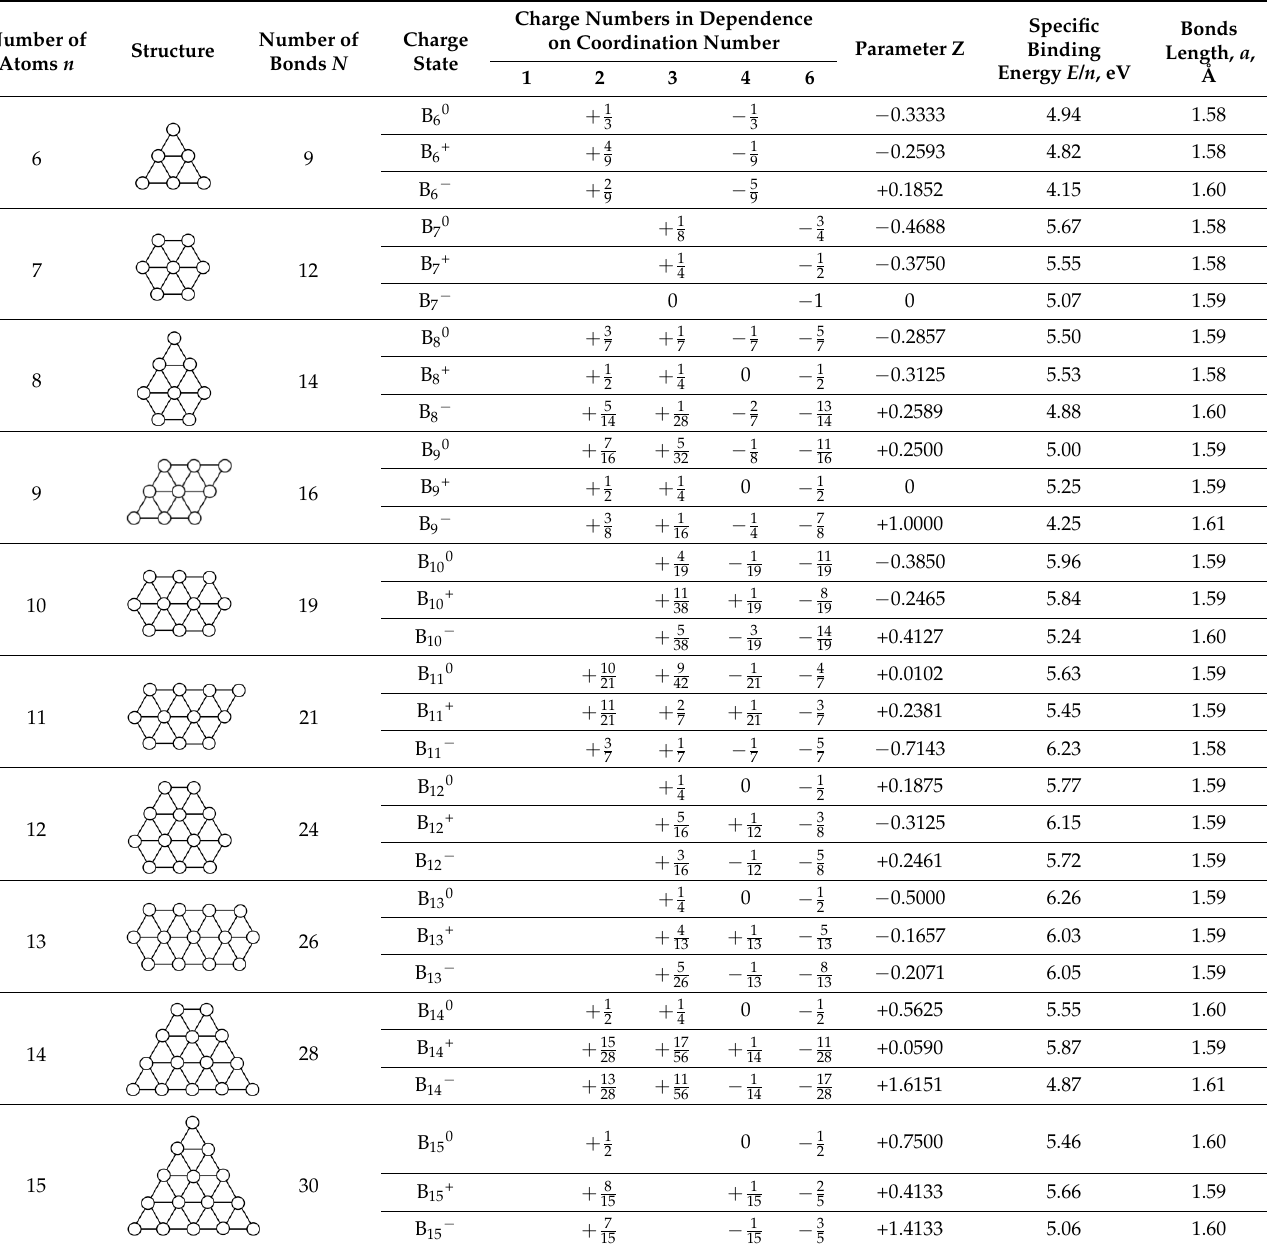
Figure 2. Specific binding energy of neutral ( ♦ ), positively ( ■ ) and negatively ( ▲ ) charged boron small planar clusters in dependence on number of atoms calculated in diatomic model. For comparison, available experimental data are presented in Figure 3. In Reference [130], clusters in boron vapor were generated by the thermal decomposition of electrode made of a boron-rich metal boride. Note that, in this way, initially clusters are formed in neutral state but then ionized by collisions with released in the chamber energetic elec- trons and accelerated toward the mass-spectrometer. Boron cluster cations were gener- ated [29] by laser evaporation of target compact made of boron dust with gold added to increase its stability. Here, a disproportionately intense peak related to traces of gold is